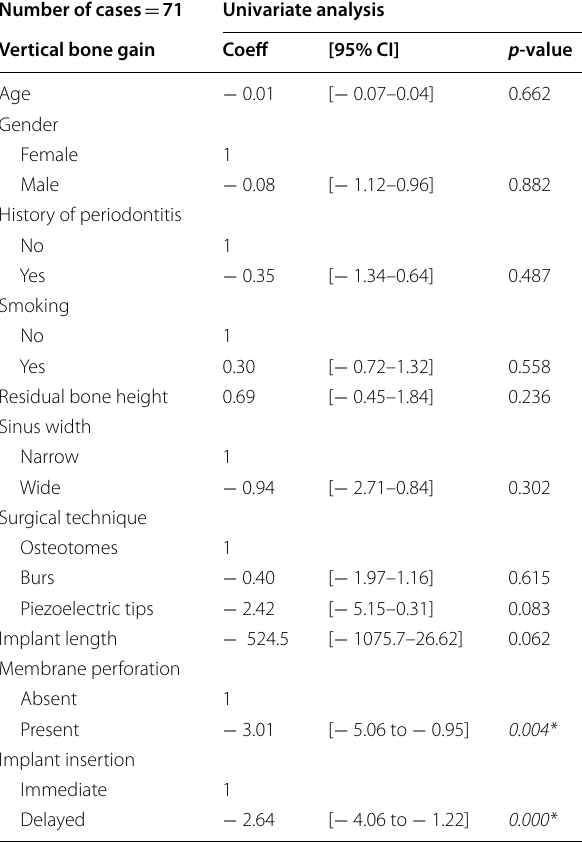
Table 2 Univariate regression model for the outcome “Vertical Bone